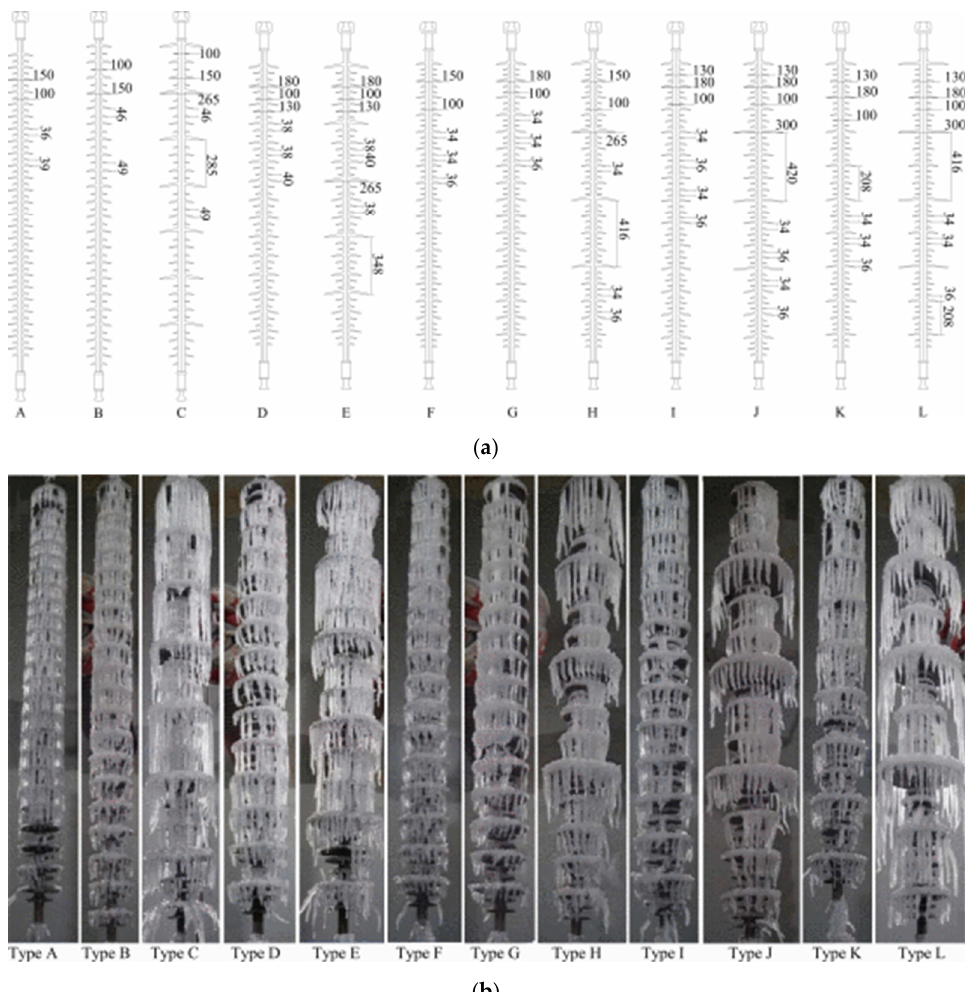
Figure 26. The contrast of parameters and icing situation of composite insulators of different types. ( a ) Insulator types. ( b ) Icing situation of different types of composite insulators [57].